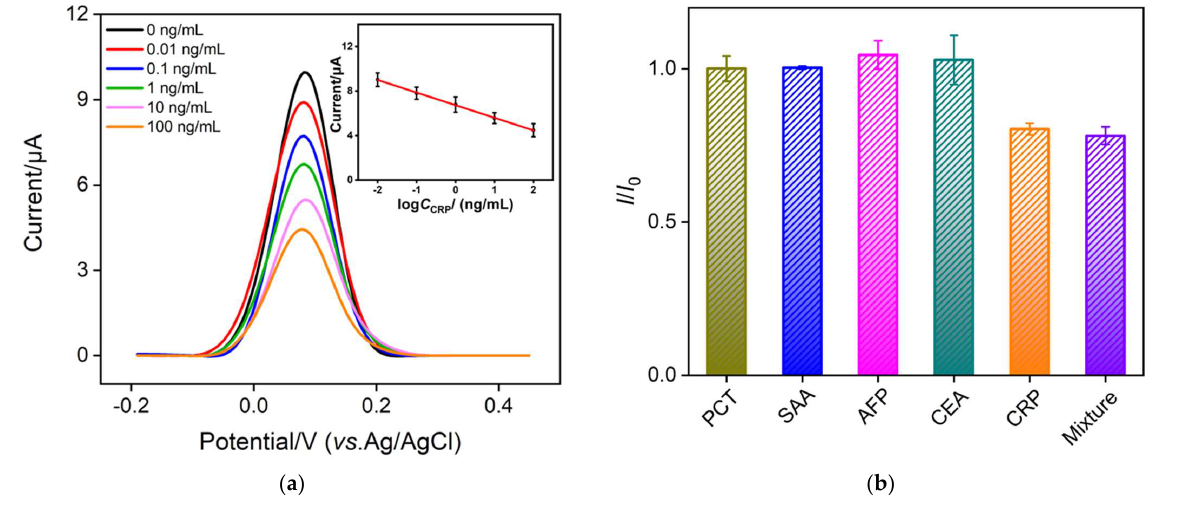
Figure 6. ( a ) Differential pulse voltametric curves of the immunosensor to various concentrations of CRP. Inset was the corresponding calibration curve for the detection of CRP. ( b ) The ratio of peak current when the immunosensor was incubated with different protein or their mixture. I 0 and I were the peak current before and after the incubation. The concentration of each protein was 1 ng/mL. The mixture contained CRP (1 ng/mL) and all other proteins (each concentration was 1 ng/mL). The immunosensors were incubated with different protein or their mixture for 60 min at 37 ◦ C. The error bars represent the relative standard deviation (RSD) of three measurements. Table 1. Comparison between the performance of different electrochemical sensors for the determina- tion of